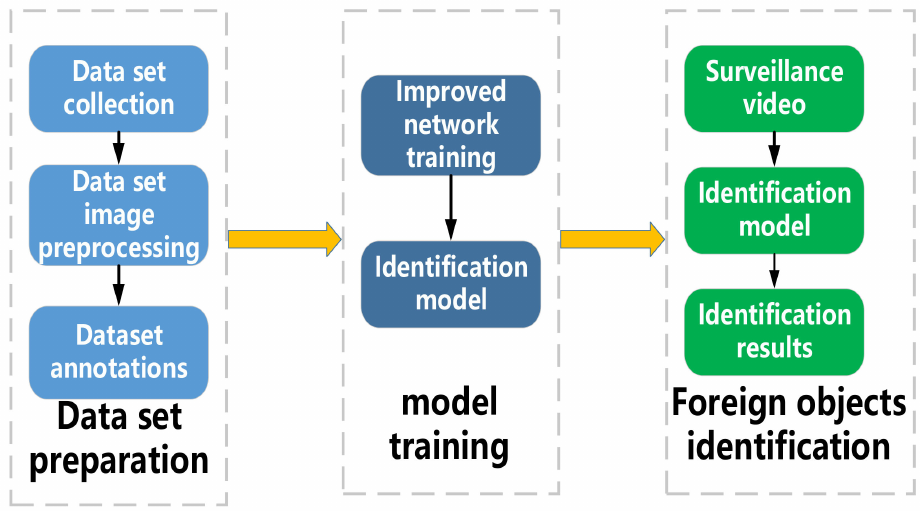
Figure 5. Identification process of foreign objects.